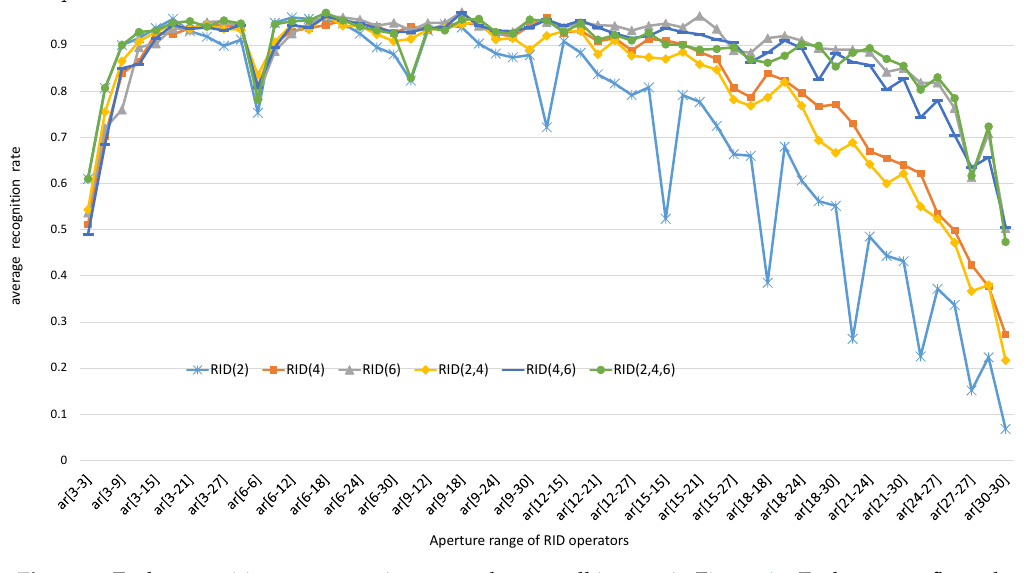
Figure 8. Each recognition rate curve is averaged across all images in Figure 4a. Each curve reflects the change of the recognition rate of RandomFerns classifier with the change of RID operator aperture. These experimental curves are obtained from rgb images and the channels of sampling cells within each RID operator are randomly specified when pre-generating RID